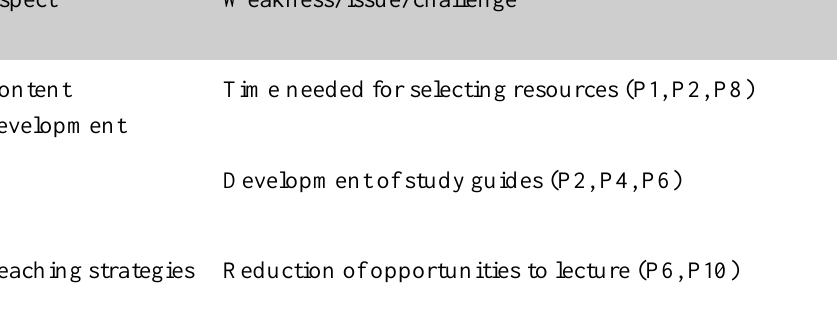
Issues and Challenges in Personal ODeL Course Design Practice